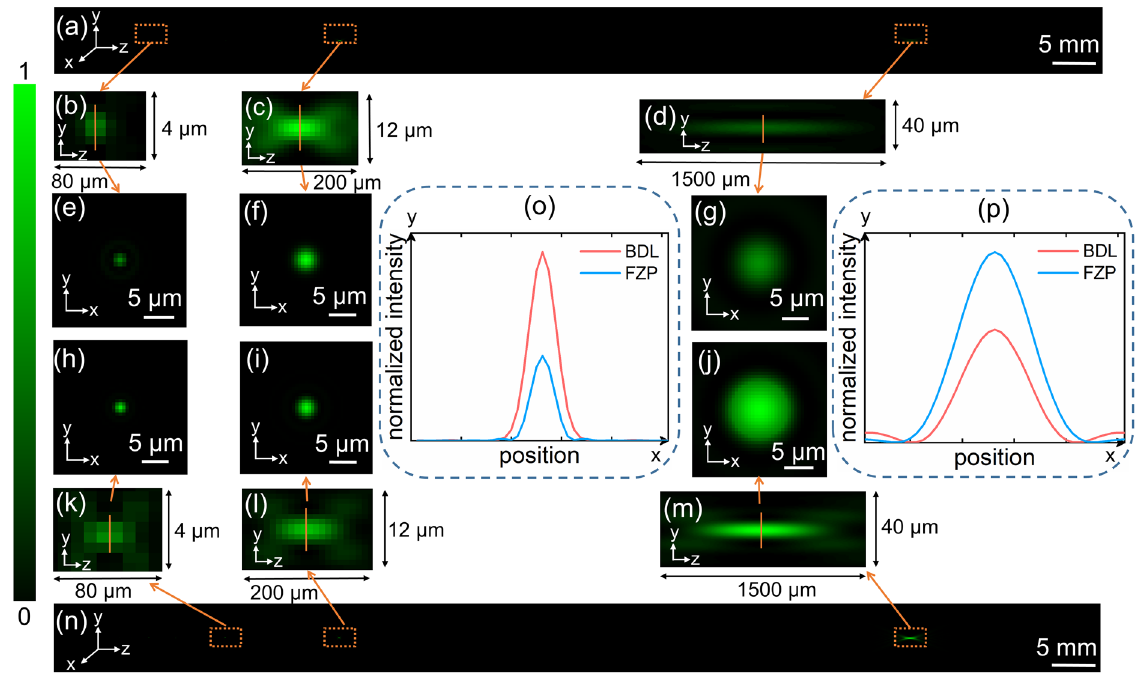
Figure. 2. Focusing properties of the BDL and FZP. ( a ) Axial intensity distribution of the BDL. ( b ) Axial intensity distribution of the third focus of the BDL. ( c , d ) Axial intensity distribution of the short and long foci of the BDL. ( e – g ) The intensities of corresponding focal spots of the BDL. ( h – j ) The intensities of corresponding focal spots of the FZP. ( k ) Axial intensity distribution of the third focus of the FZP. ( l , m ) Axial